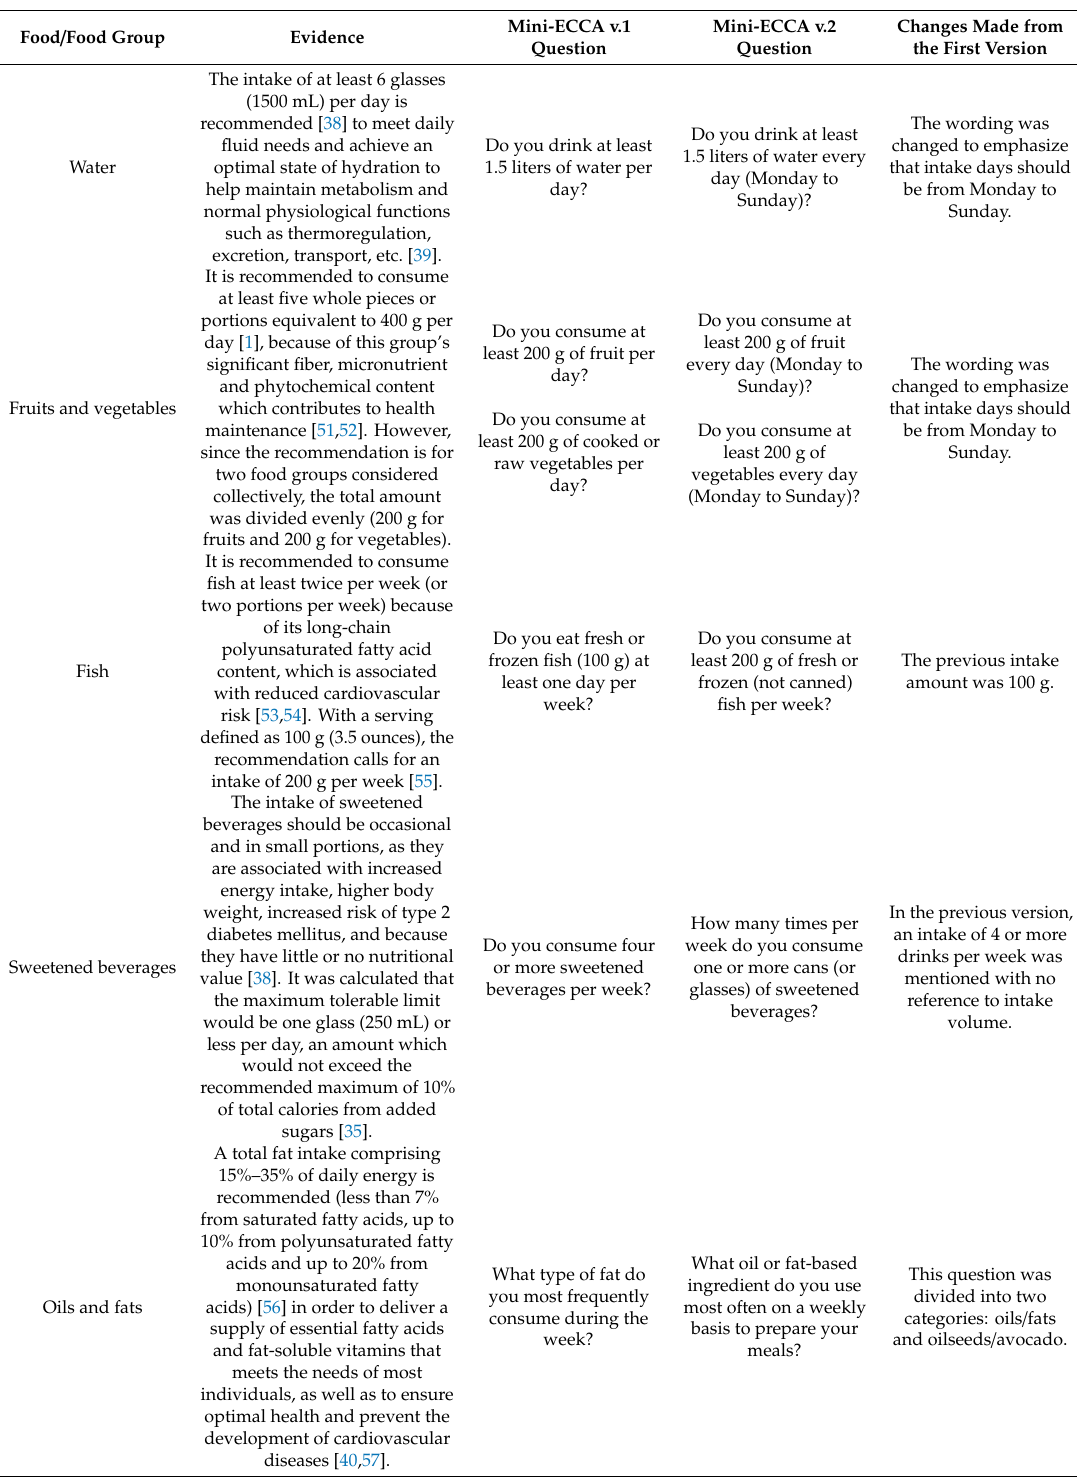
Table 1. Recommendations on which the changes to each question in the Mini-ECCA v.2 were based. Food / Food